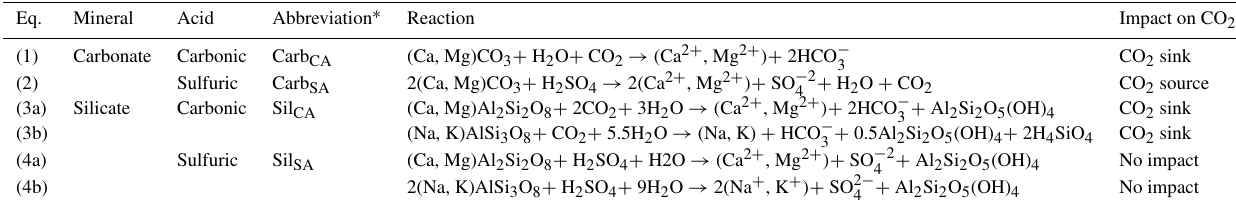
Table 1. Mineral weathering reactions and impacts on dissolved CO 2